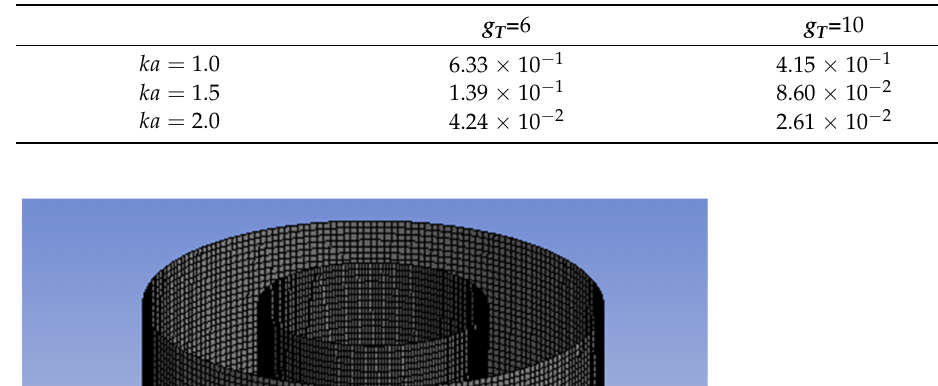
Table 2. Inner pressure p in 0 / ( H /2 ) with respect to various values of g T and k a for the restrained OWC [26].